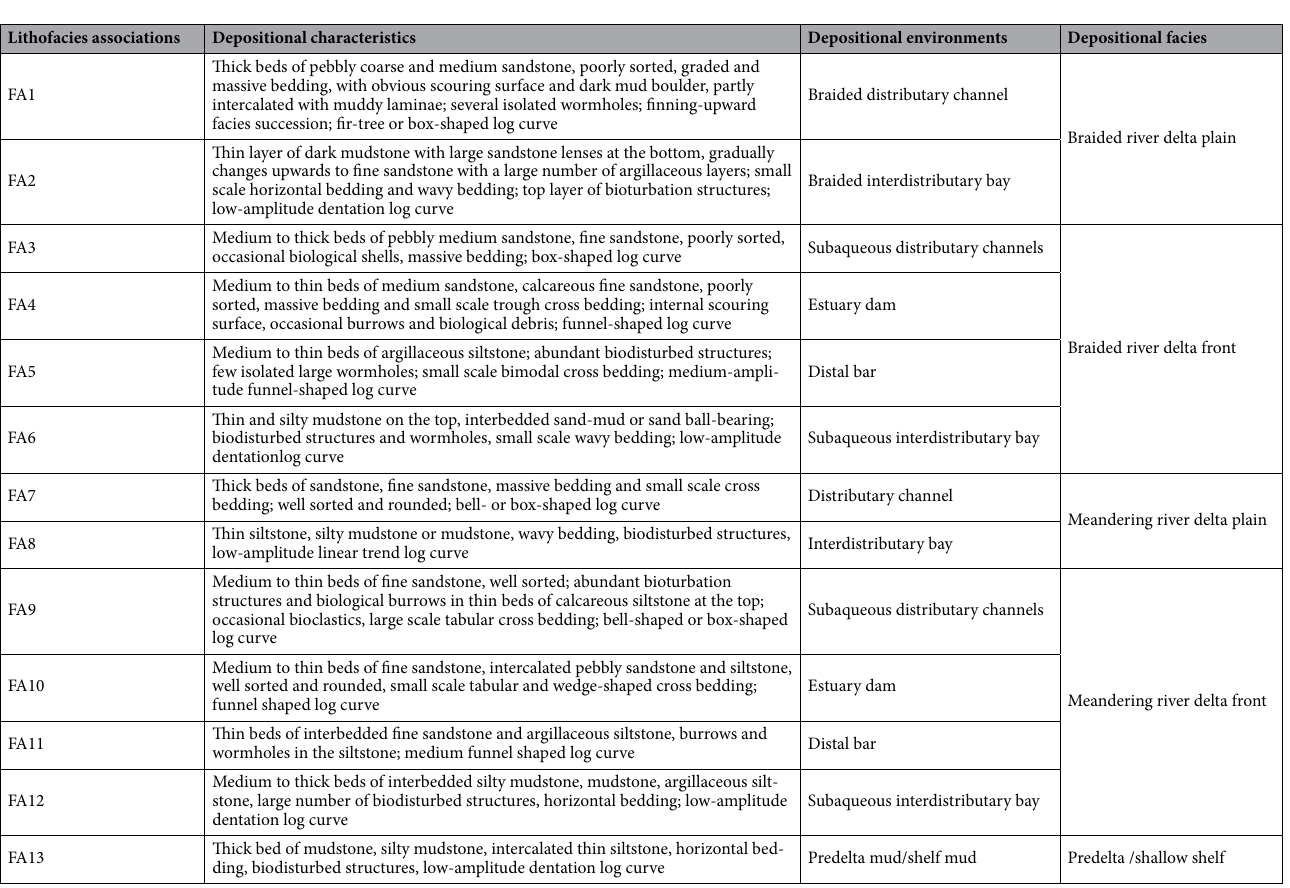
Table 1. Main lithofacies associations of braided and meandering river deltas from the Early-Mid Miocene in the study